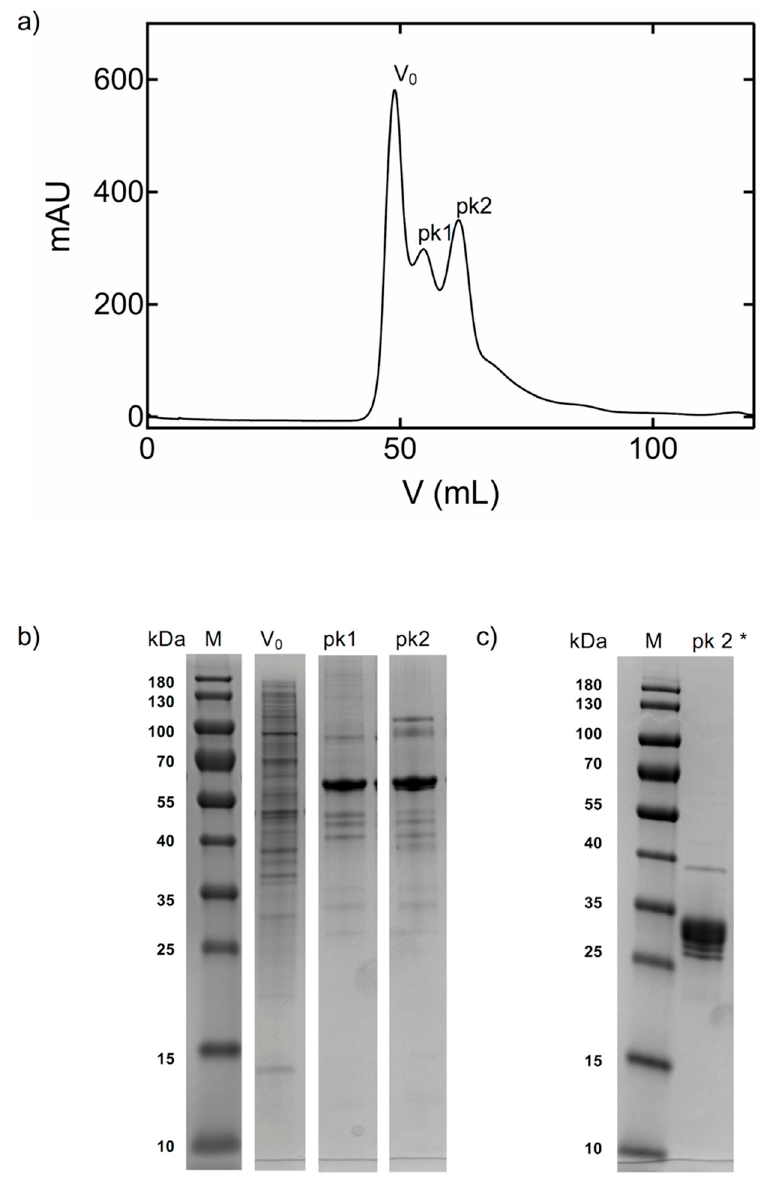
Figure 2. Chromatograms and SDS-PAGE from size exclusion chromatography peaks (Superdex 200 16 / 600, GE Healthcare, Chicago, IL). ( a ) CA IX elutes after the expected void volume (V 0 ) as peak 1 (pk1) and peak 2 (pk2). X-axis indicates fractions and volume; Y-axis is absorption units; ( b ) SDS-PAGE (18%) stained with Coomassie Brilliant Blue. Molecular masses (M) of broad range protein marker (10–180 kDa) (Thermo Scientific) are indicated in kDa. Analysis of peak fractions corresponding to peak 1 and peak 2. ( c ) “degraded” peak 2 (marked as pk 2 *) after 6 months storage at 4 . ℃